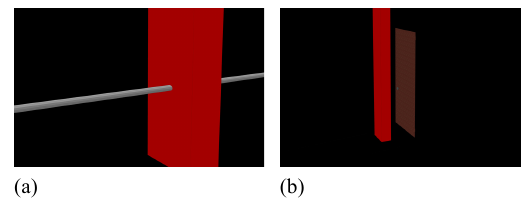
Figure 2. (a) Hard clash between a pipe and a beam; (b) Soft clash between a door and a beam.